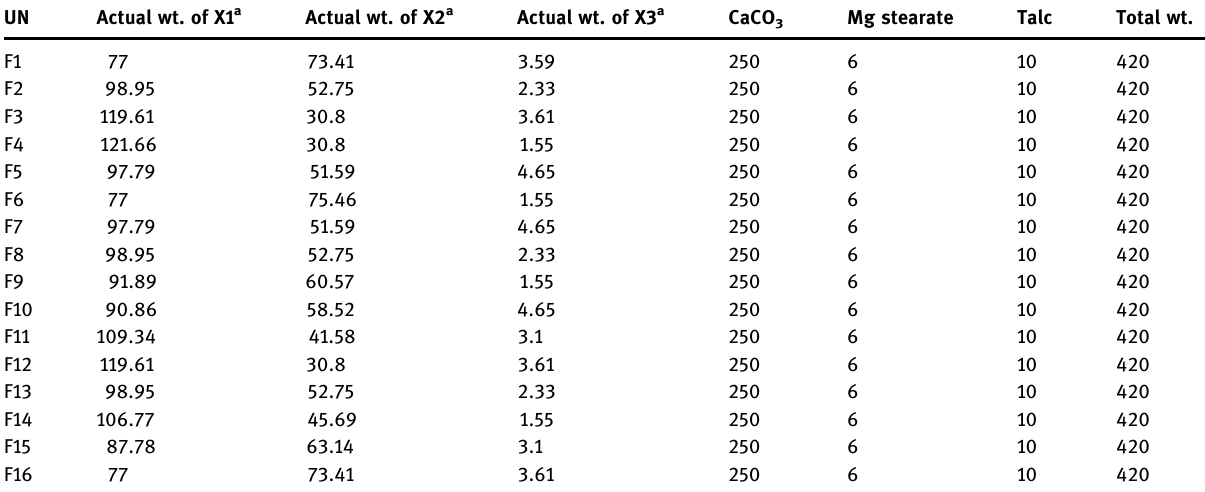
Table 2: Composition of the model formulations ( in mg ) as per D - optimal mixture design UN Actual wt. of X1 a Actual wt. of X2